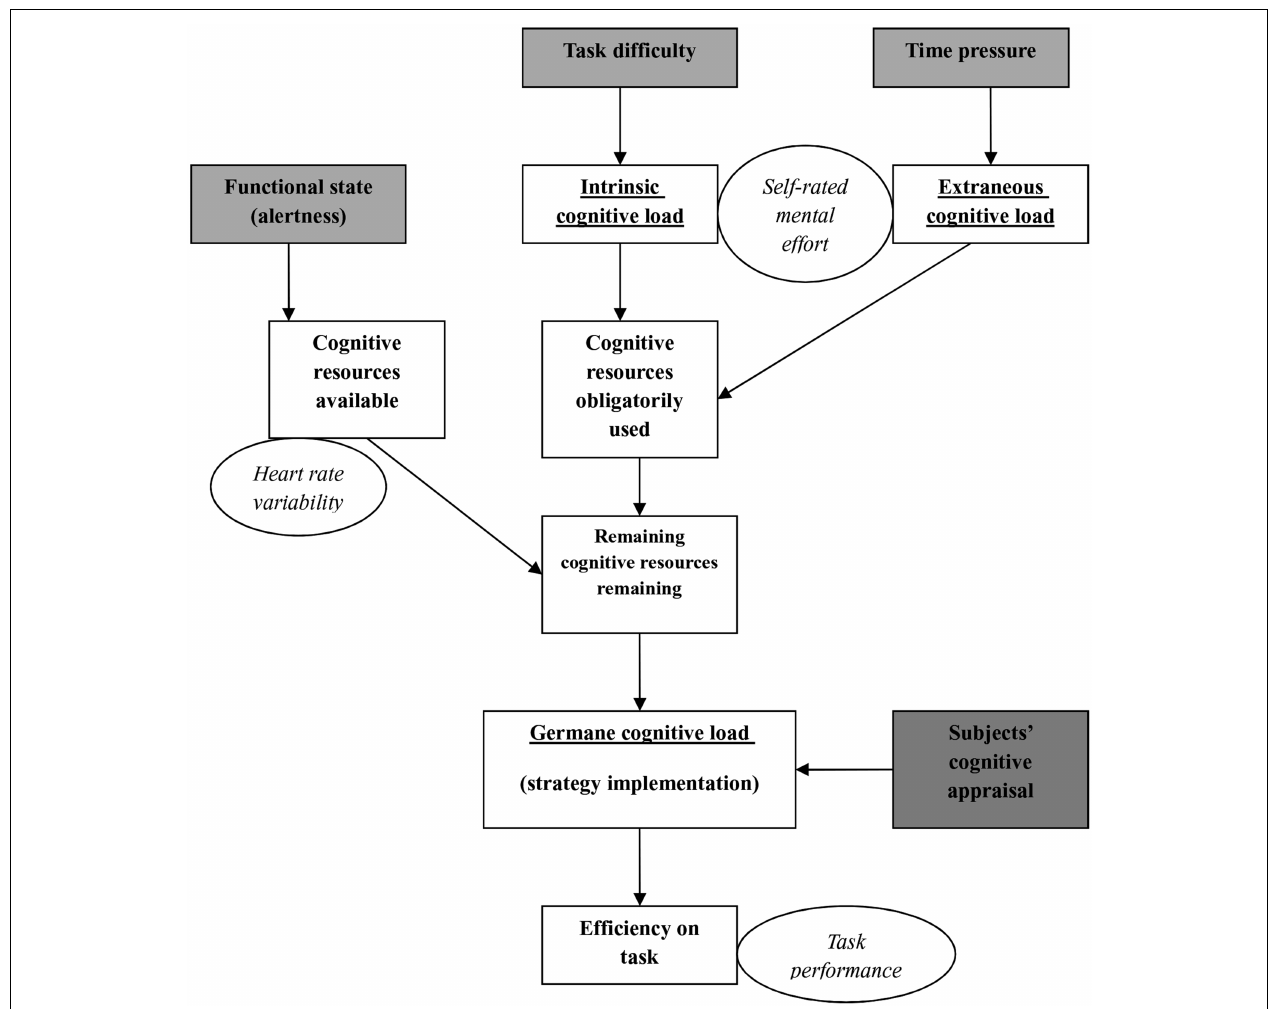
FIGURE 1 | Graphical representation of putative relationships between cognitive load factors and cognitive load categories in working memory tasks (Galy etal.,